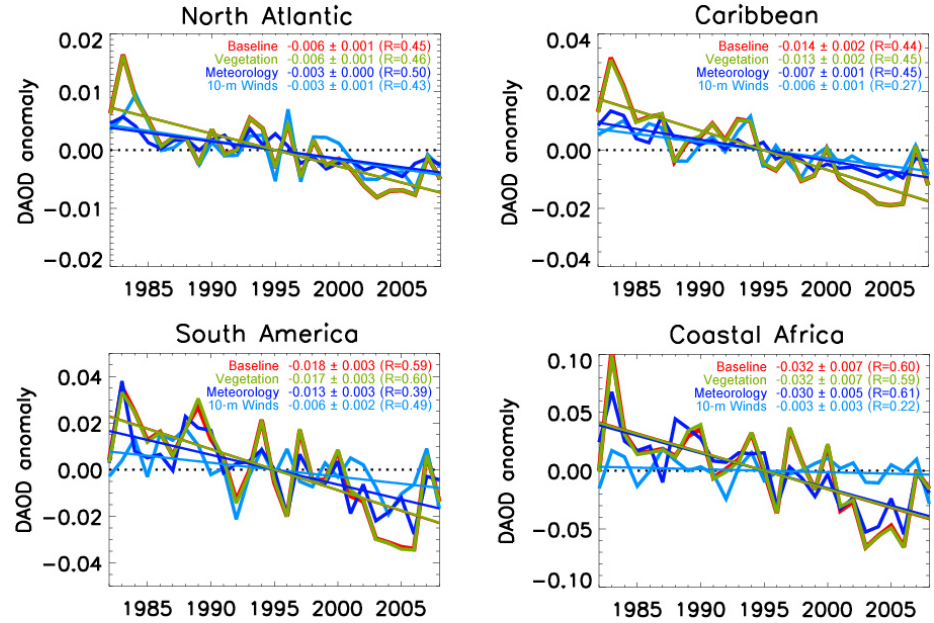
Figure 6. Annual dust AOD (DAOD) anomalies are shown for the updated model (red, same as the model in Fig. 2), with interannual variability in 10m winds removed (light blue), with interannual variability in all meteorology, except surface winds, removed (dark blue), and with interannual variability in vegetation cover removed (green). Thin solid lines show the trends, and the trend and one standard deviation uncertainty shown in each panel for the observations and the model. The correlation between observed dust AOD and each version of the model is shown in brackets. NB the red line is almost always obscured by the green line.